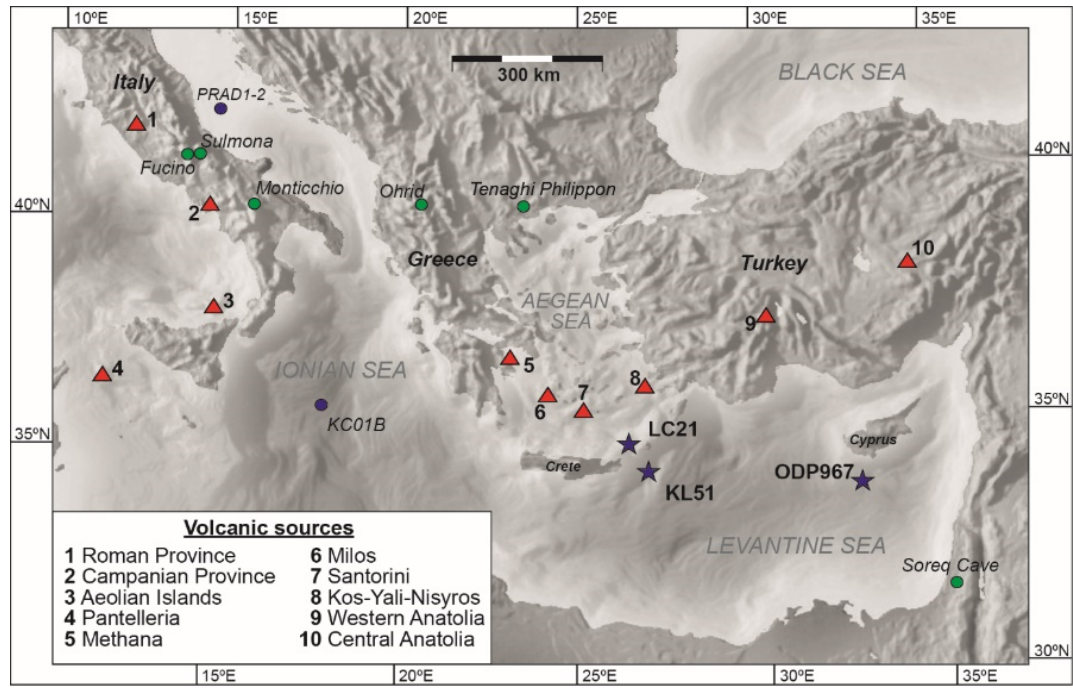
Figure 1. Map of the Eastern Mediterranean showing the locations of marine cores sampled in this study (purple stars: LC21, KL51 and ODP967), the potential tephra source regions (red triangles: numbered 1–10), and other locations mentioned in the text (purple circles are marine sediment cores, green circles are terrestrial environmental records).